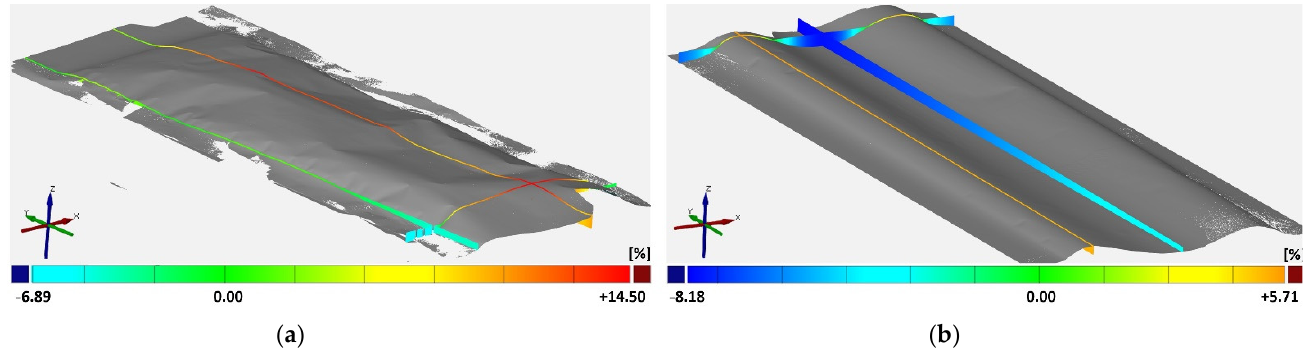
Figure 5. The geometric shape of calendered hard carbon (single-sided): ( a ) sample No. 2 maximum compaction rate; ( b ) sample No. 3 low compaction rate .